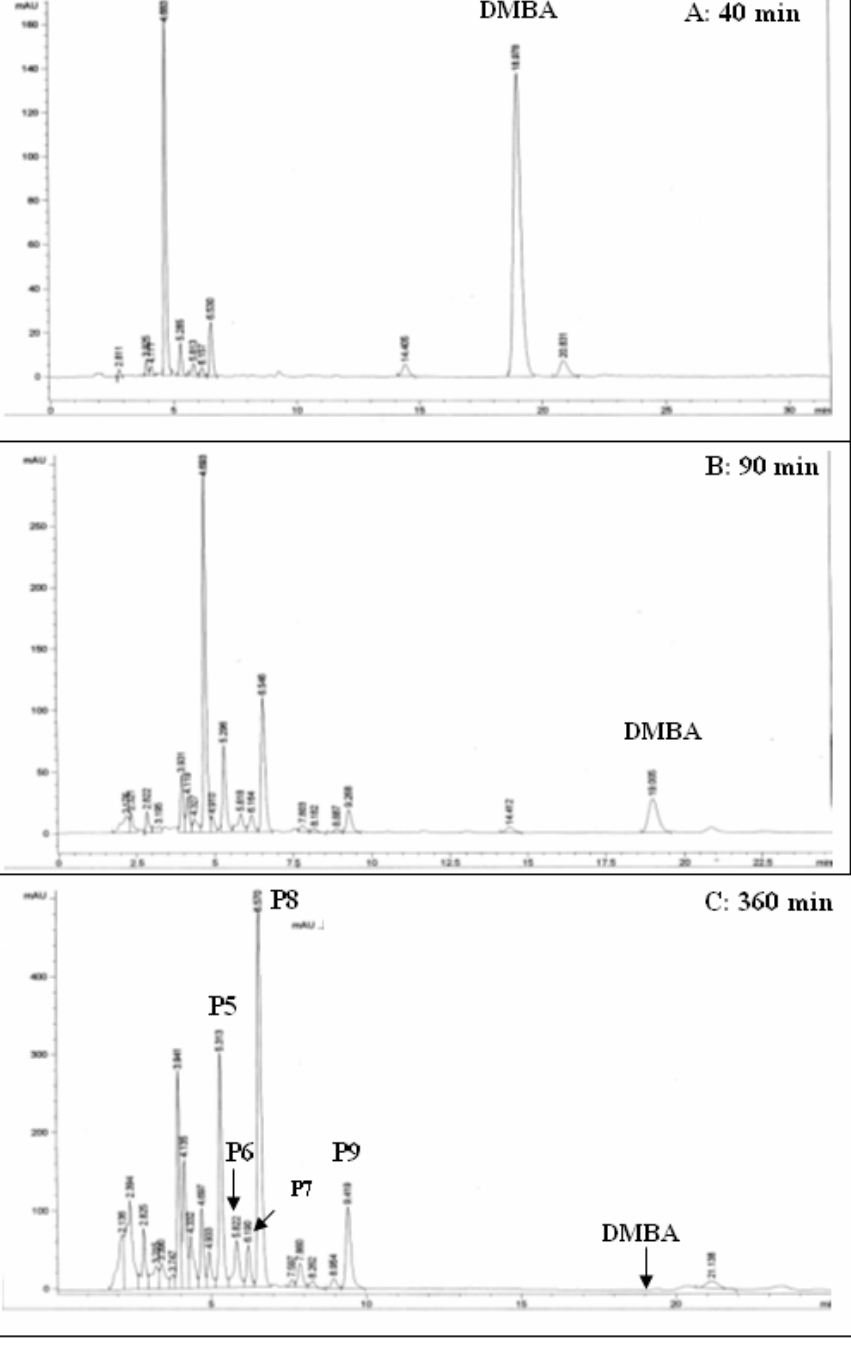
Figure 1: HPLC profiles of photoproducts of DMBA after irradiation with UVA light (2.6 J/cm 2 /min) in ethanol for (A) 40 min; (B) 90 min; (C) 360